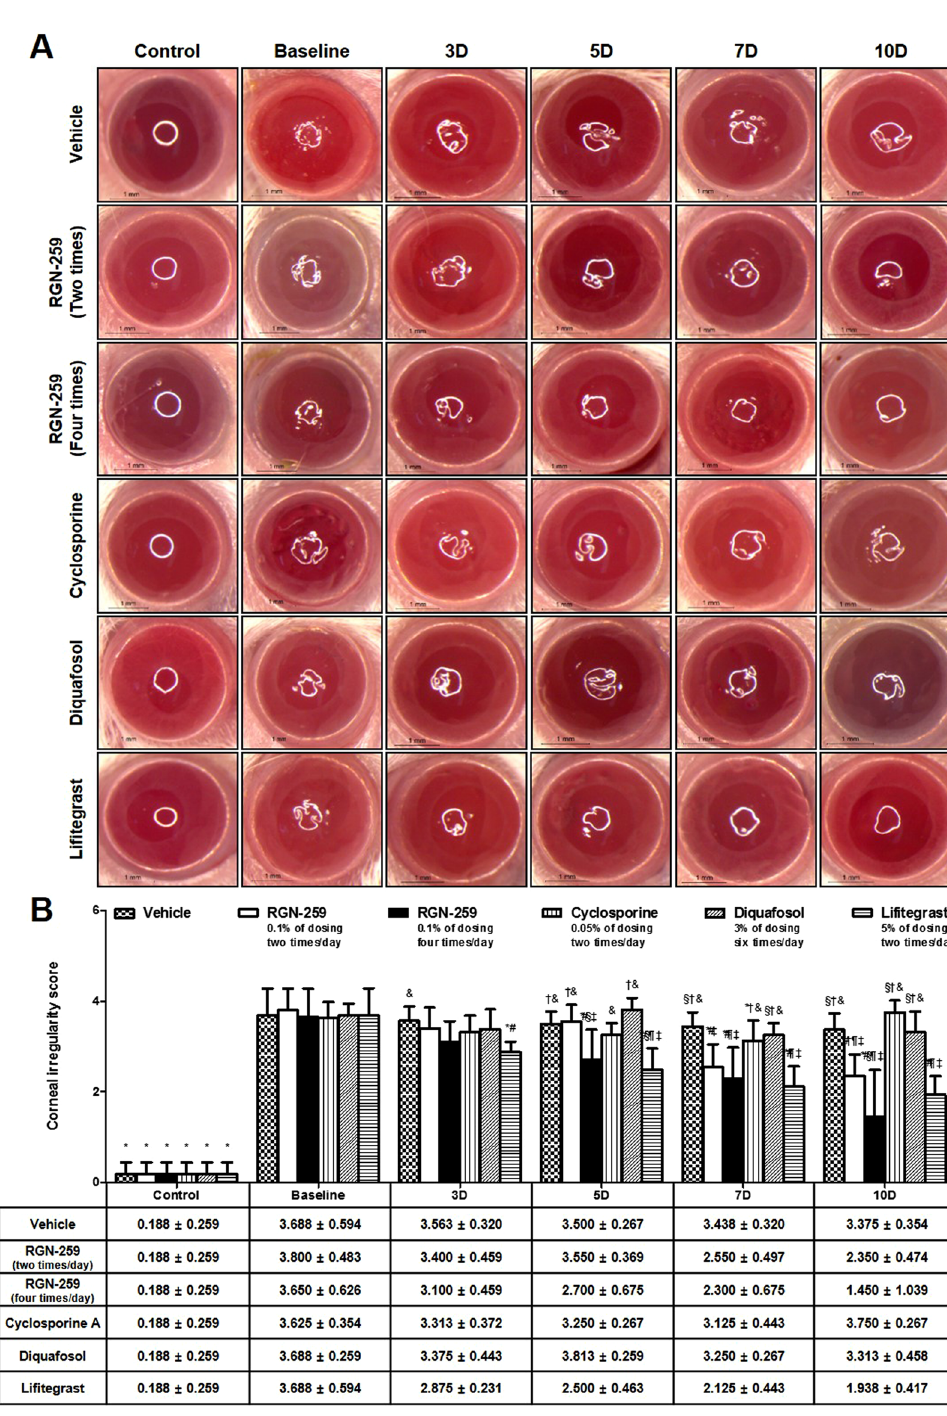
conjunctiva increased by 2.4-, 2.6-, and 2.4-fold in the groups treated 2 and 4 times per day with RGN-259 and with CsA (12.095 ± 1.438, 13.143 ± 1.030, and 12.381 ± 0.595 cells/0.1 mm 2 , P < 0.05, respectively). The mucin staining in the conjunctiva increased by 1.1-, 1.3-, and 1.5-fold in the vehicle-, DQS-, and LFA- treated groups (5.619 ± 1.574, 6.571 ± 0.857, and 7.14 ± 1.714 cells/0.1 mm 2 ), respectively, when compared with the baseline